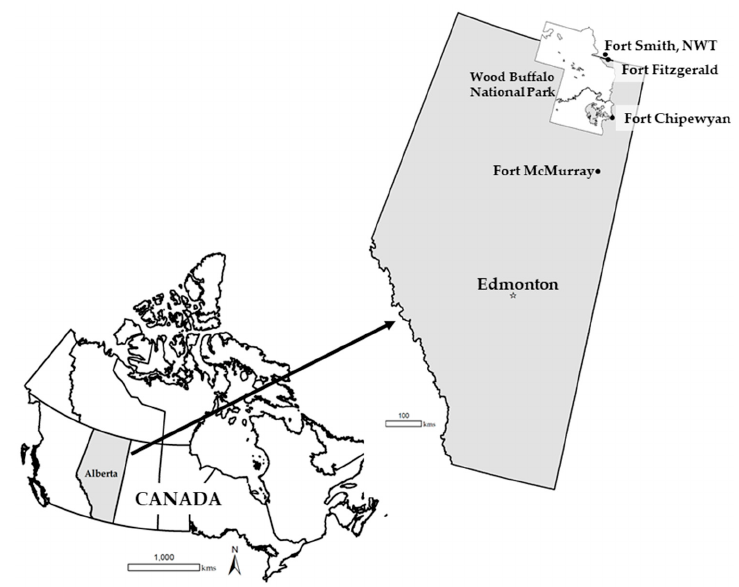
Figure 1. Study area including key communities involved in the project, and the Wood Bu ff alo National Park,